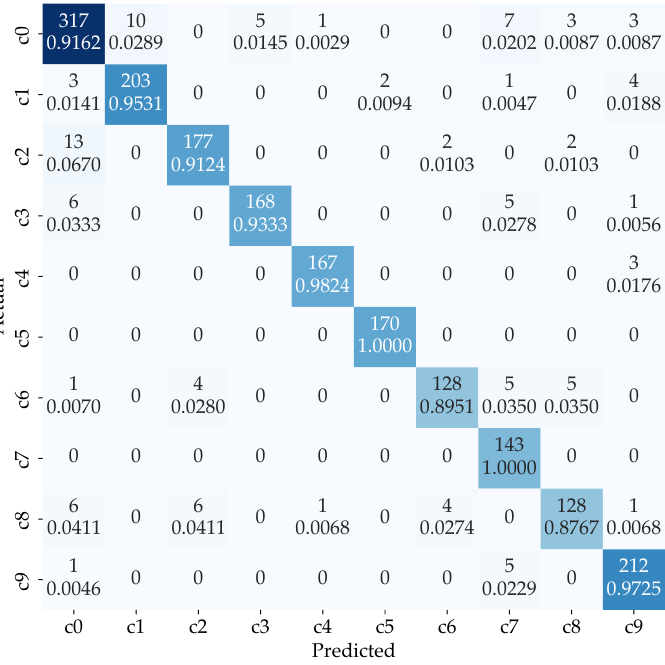
Figure 7. Confusion matrix for the ensemble of ResNet101 model for original dataset classification and ResNet50 model for pose classification with weight.